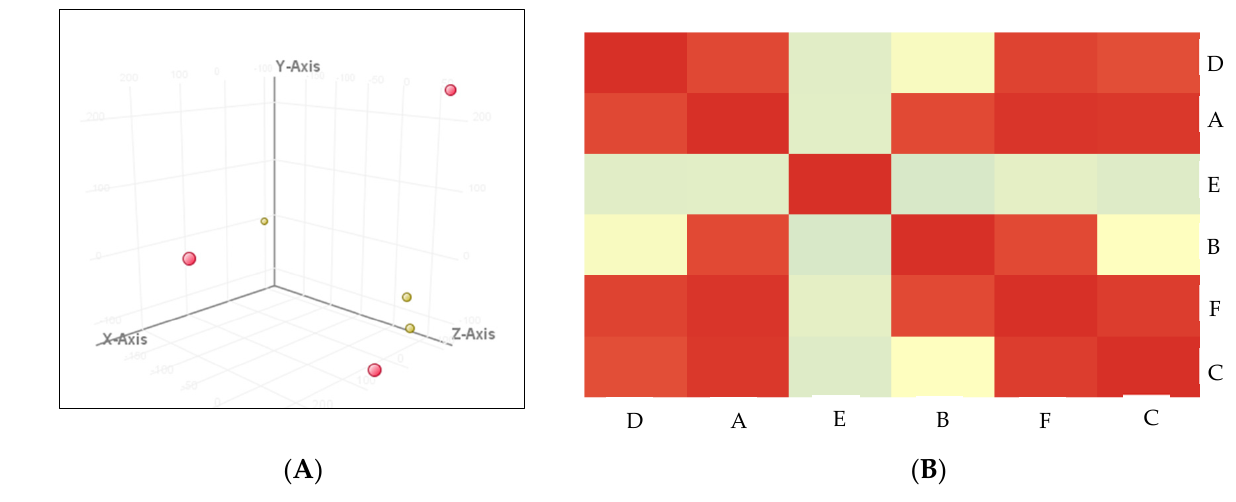
Figure 2. Sample quality. ( A ) PCA plot. Yellow dots are non − POCD samples; red dots are POCD samples. ( B ) Correlation analysis. A, B, and C are non − POCD samples, while D, E, and F are POCD samples. Darker red means higher correlation between samples. Table 3. Differentially expressed genes in the POCD Table 2. Purity, concentration, and integrity of RNA samples.